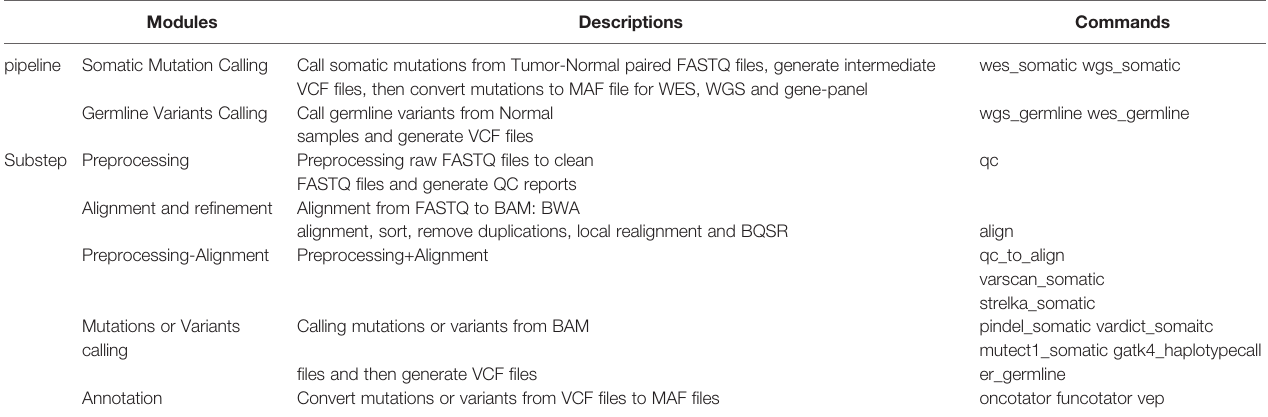
TABLE 2 | Descriptions of DIVIS modules “ Pipeline ” and “ Substep ” .